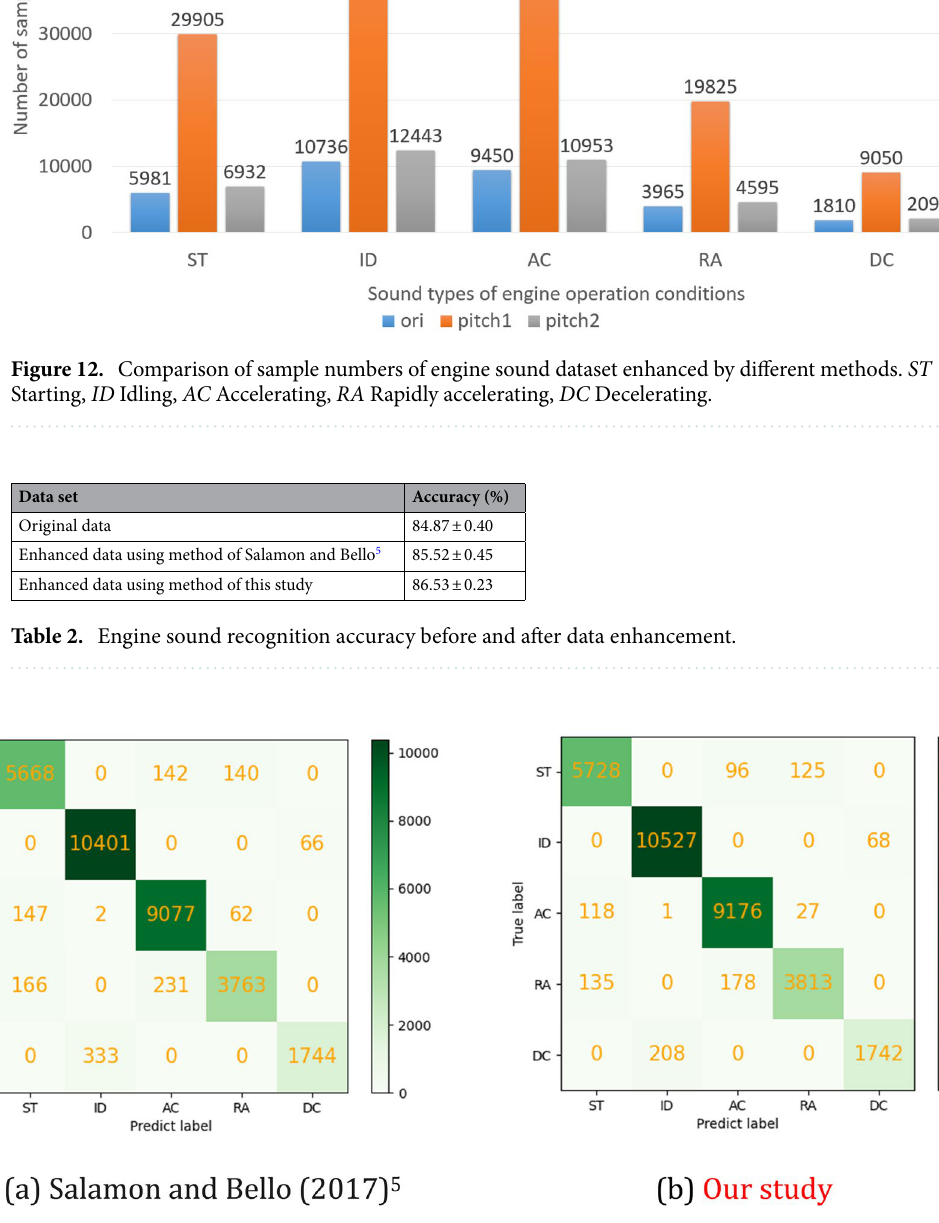
Figure 13. Confusion matrix of engine sound accuracy rate under different data enhancement